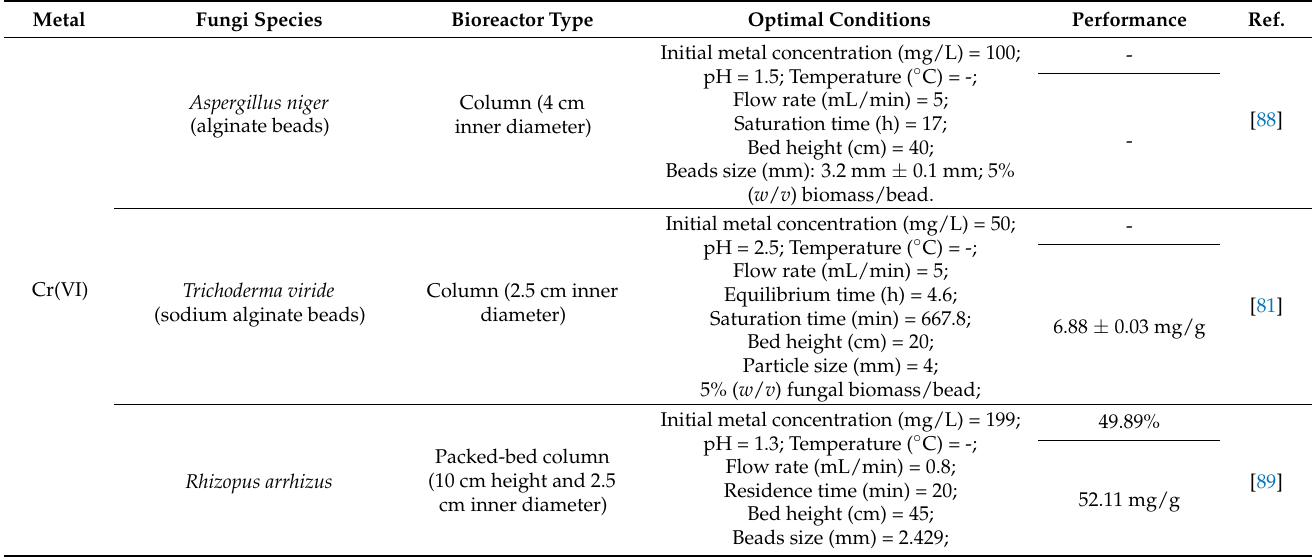
Table 4. Removal of heavy metals in a continuous system using fungal